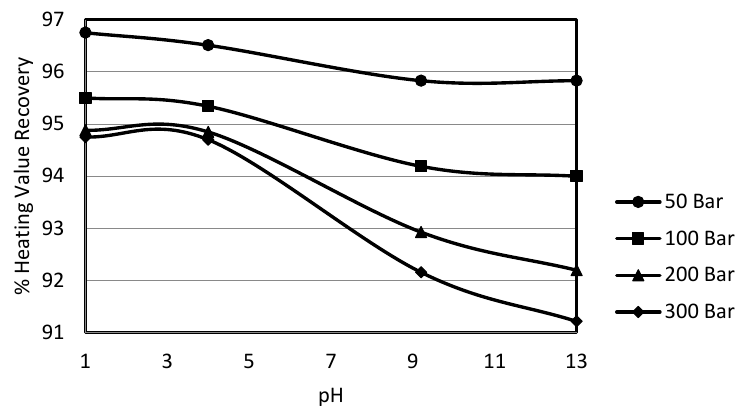
Figure 12. Effect of pH on organic sulphur removal.